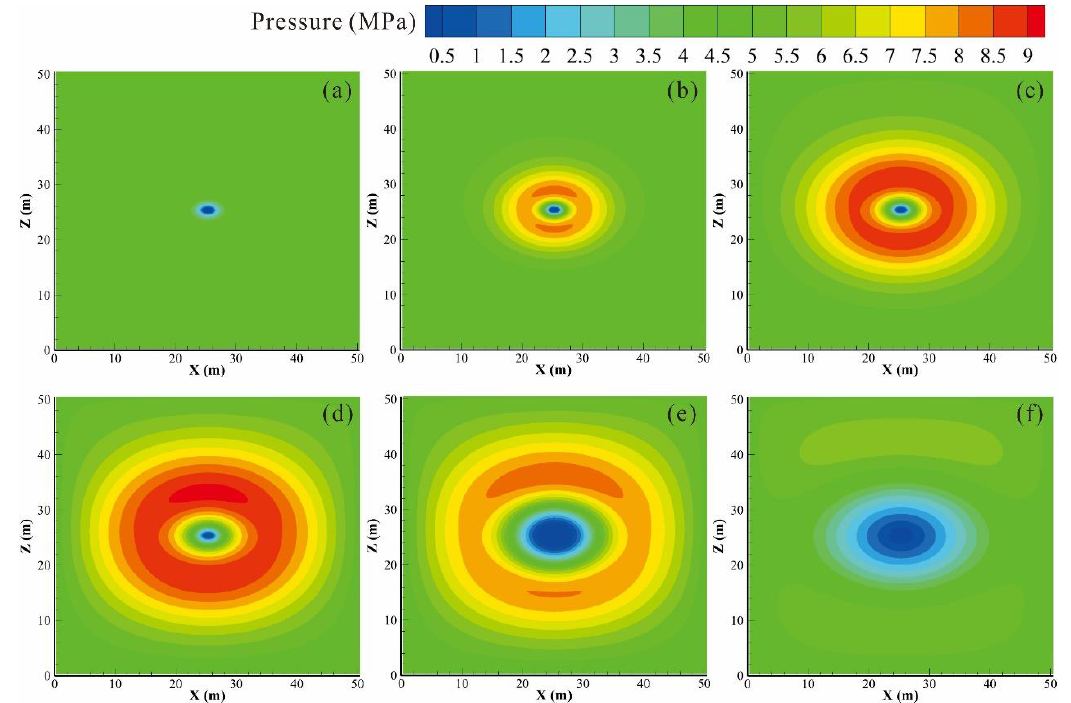
Figure 14. Spatial distributions of model predicted pore pressure at ( a ) 496.5 days, ( b ) 938.5 days, ( c ) 1668.5 days, ( d ) 2763.5 days, ( e ) 3128.5 days, and ( f ) 4588.5 days.